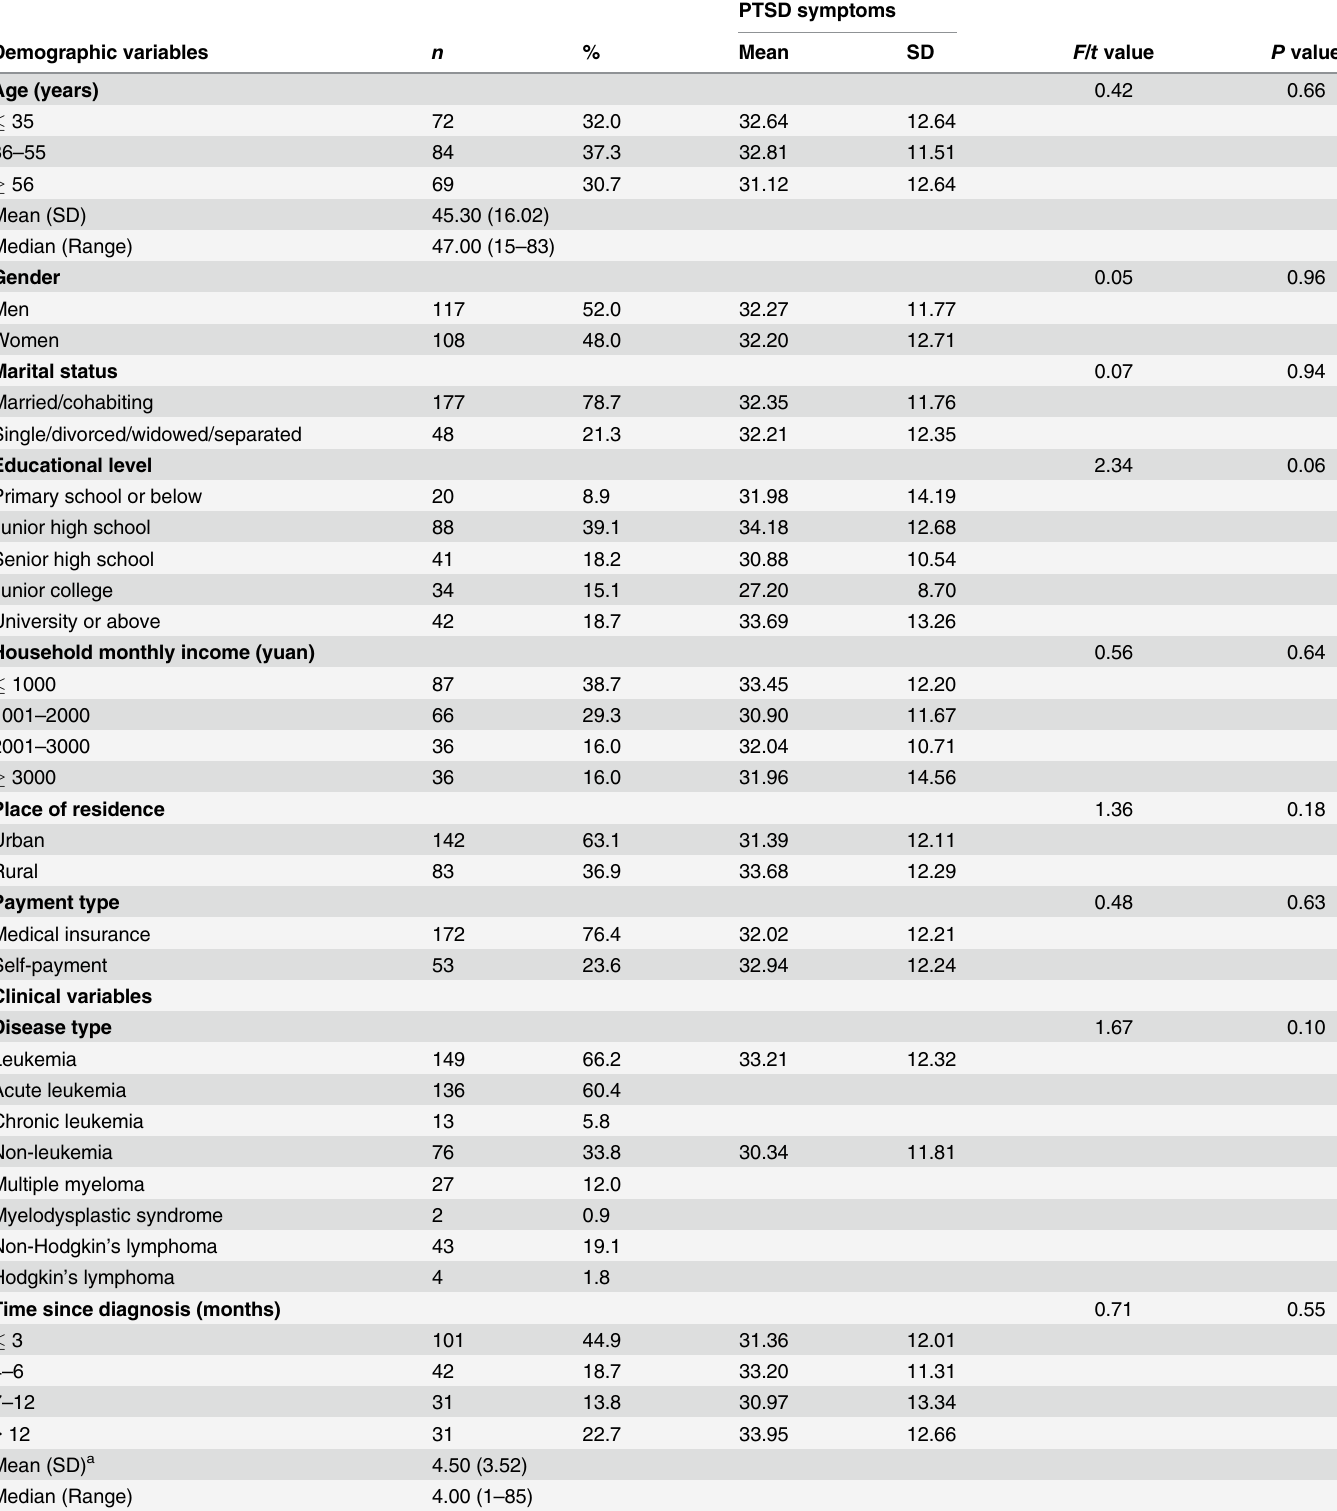
Table 1. Demographic and clinical variables of participants in relation to PTSD symptoms.